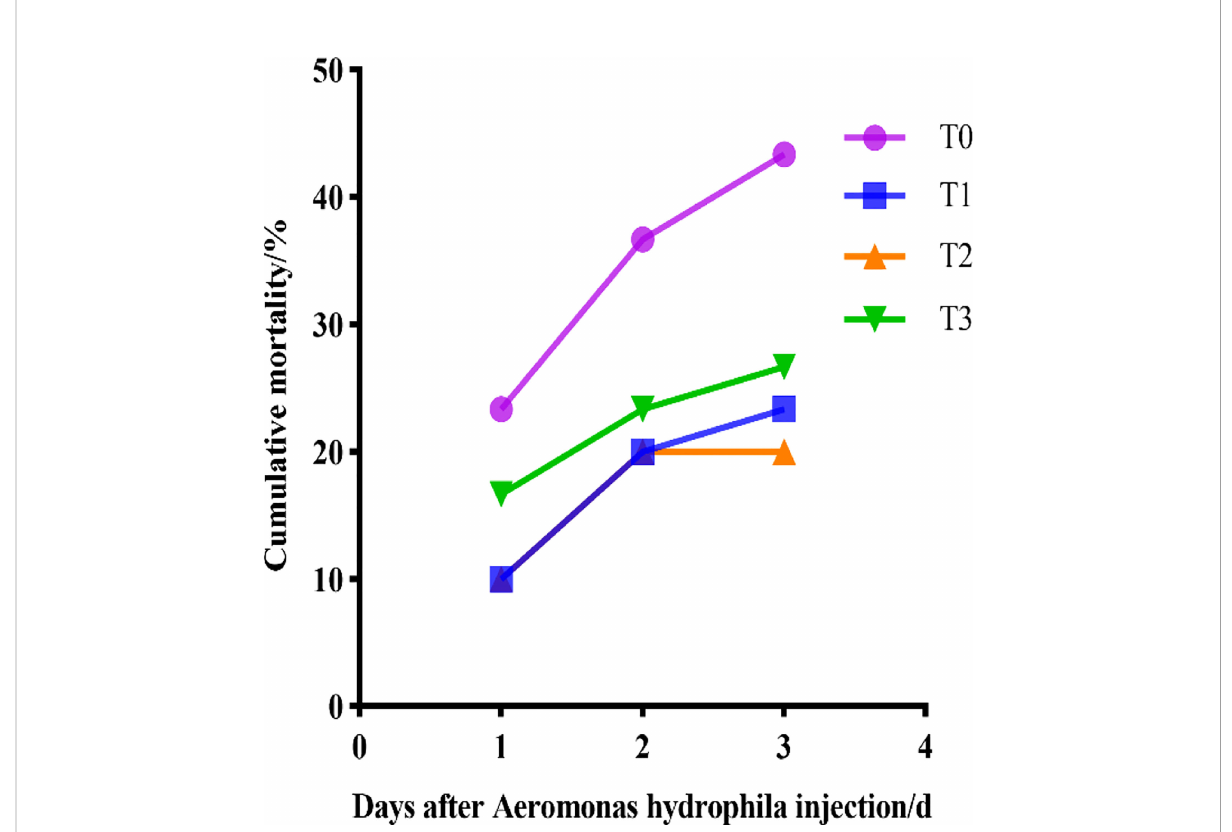
FIGURE 1 Cumulative mortality of juvenile largemouth bass after injected with A.hydrophila